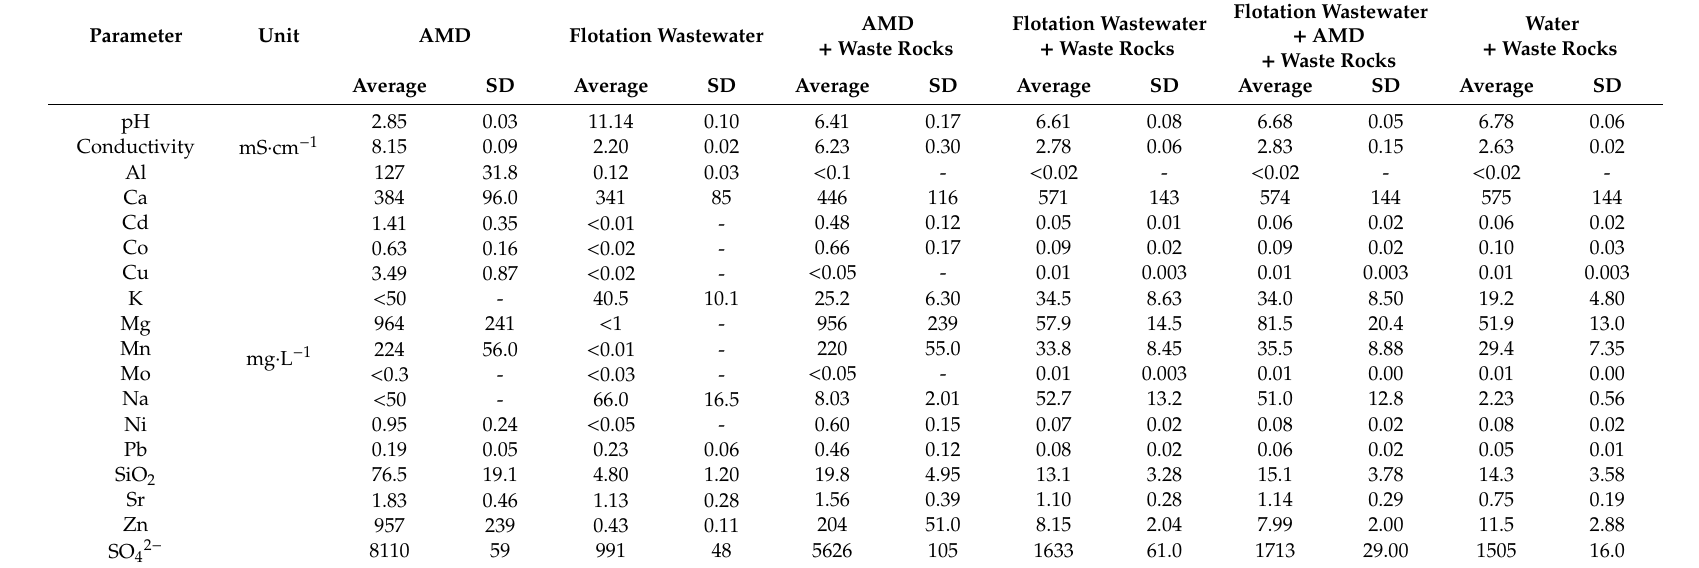
Table 7. Comparison of the selected results of physicochemical parameters of flotation wastewater, AMD, and mixtures of long-term stored waste rocks, and proposed